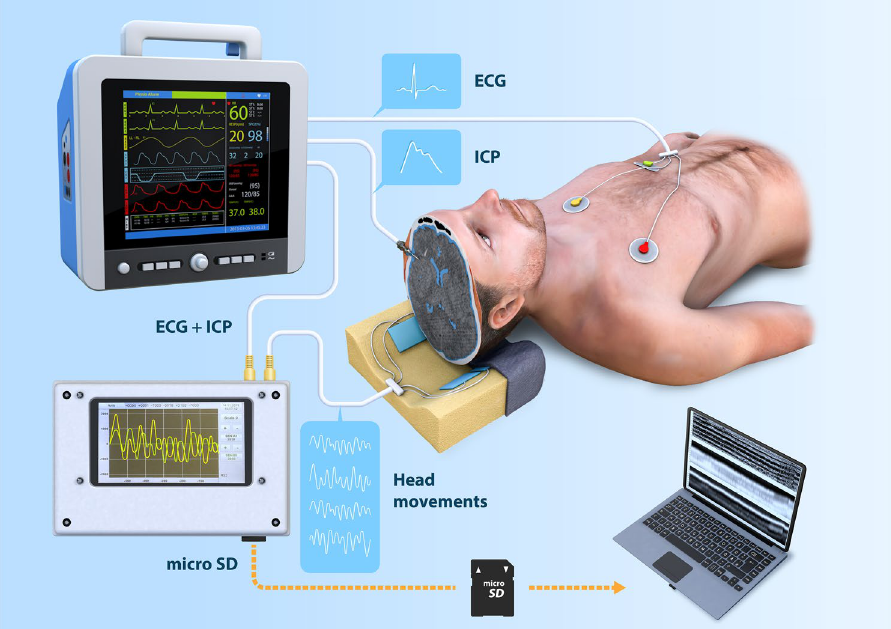
Figure 1. The measurement set-up. The head micro-motions were detected using four pillow-embedded sensors. Along with the ECG and ICP signals acquired through a bedside monitor, the time series were recorded on-the-fly using an in-house built logger. Please note that the figure is only for illustrative purpose and does not reflect the actual measurement setting, e. g. in the actual setting the patient’s head was elevated by 40° throughout the measurement. The figure was generated using Adobe Photoshop 2020, Adobe Illustrator 2020 (both https:// www. adobe. com/) and Cinema 4D, version R20 (https:// www. cinem a4d.